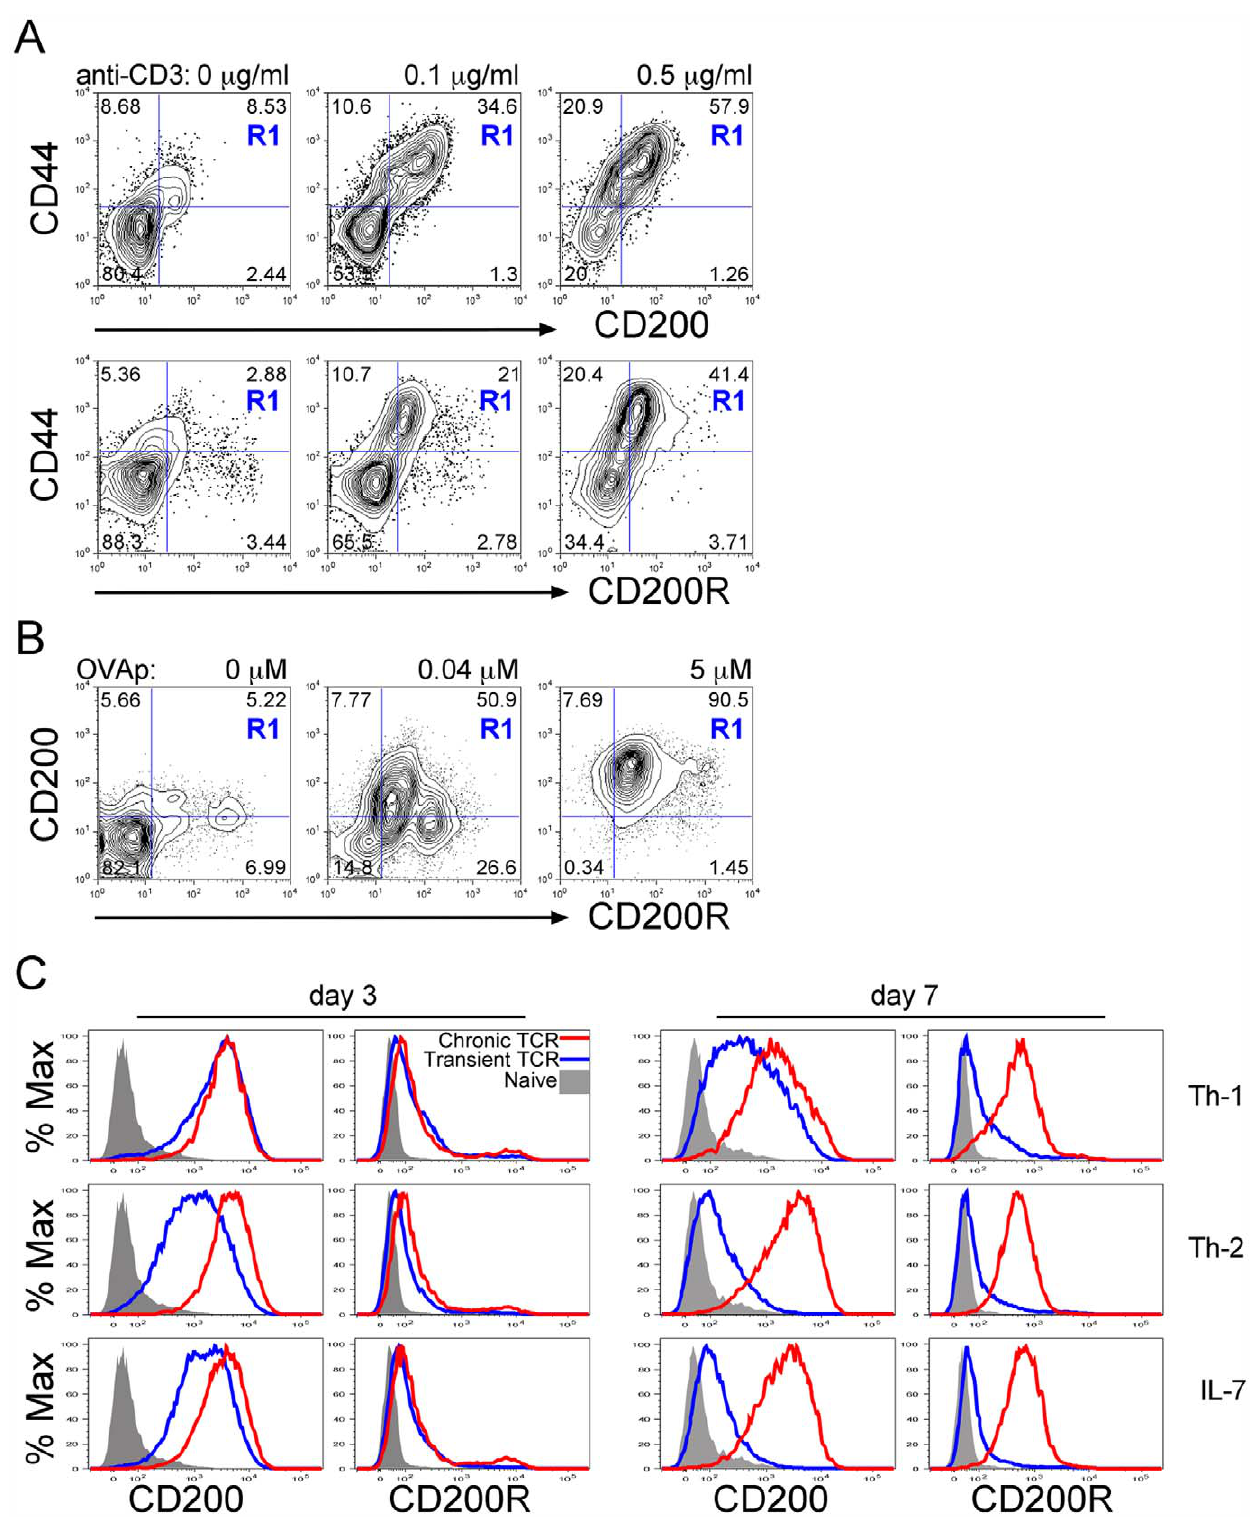
Figure 1. T cells co-express CD200 and CD200R following TCR activation. A. Naı¨ve C57BL/6 peripheral LN cells were cultured with a titration of anti-CD3 + anti-CD28 (2 m g/ml) for 3d. Contour plots show upregulation of CD200 (upper row) and CD200R (lower row) together with CD44 (R1) in gated CD4 cells. B. DO11.10 LN and spleen cells were cultured with a titration of OVA peptide (ISQAVHAAHAEINEAGR) for 3d. CD200R:CD200 co- expression (R1) is shown in gated CD4 cells. C. Naı¨ve LN cells were stimulated with anti-CD3 (1 m g/ml) + anti-CD28 (2 m g/ml) either transiently on Ab- coated wells for the first 2d then removed to fresh media (blue lines) or chronically with Ab-coated aAPC present throughout the culture (red lines) in Th1 (top row), Th2 (middle row) or non-polarising (IL-7, bottom row) conditions. Histograms show expression of CD200 and CD200R in gated CD4